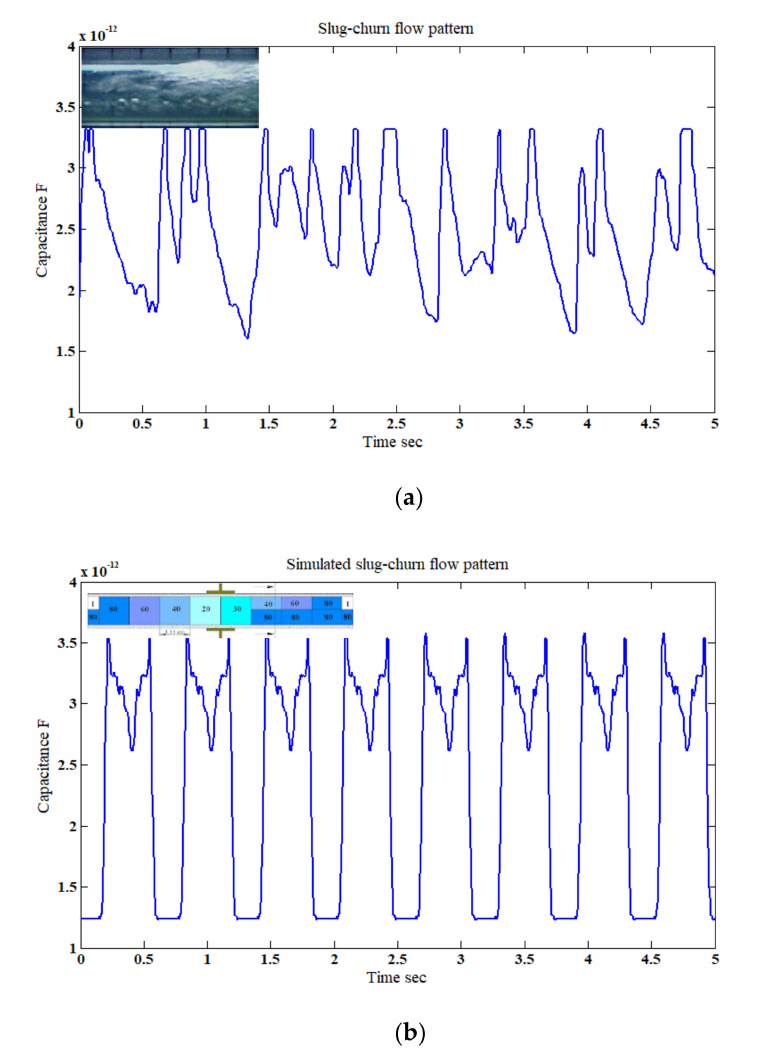
Figure 11. The time-dependent fluctuation of the capacitance value for the slug–churn flow pattern: ( a ) experimental [32], and ( b ) simulation (for the superficial gas–liquid phase velocities of 3 m / s and 0.75 m / s, respectively; inclination angle β = 0 ◦